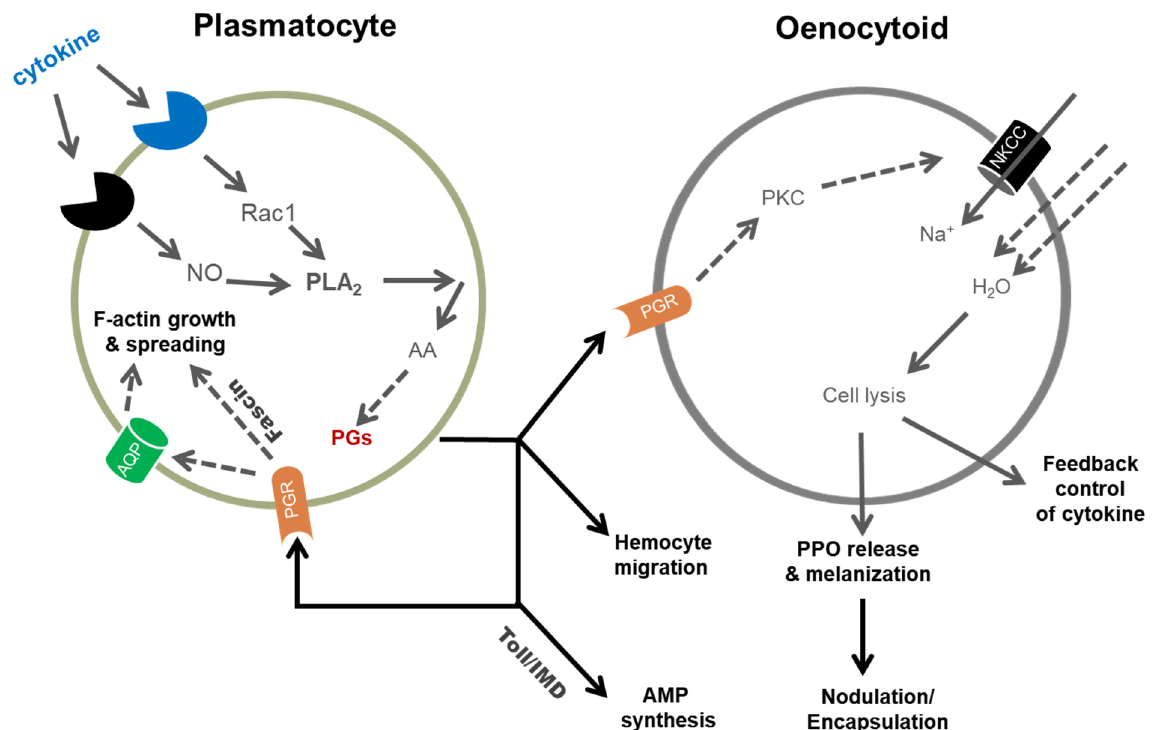
Figure 2. Prostaglandins (PGs) mediate cellular and humoral immune responses through specific receptors (PGRs). PGs are synthesized from arachidonic acid (AA), which is released from phospholipids by phospholipase A 2 (PLA 2 ) and is activated by immune challenge via cytokines or nitric oxide (NO). Oenocytoid cell lysis is mediated by PGR through a PKC pathway to activate a sodium-potassium-chloride cotransporter (NKCC), which generates an osmotic gradient that pulls water into the cell. Prophenoloxidae (PPO) is released from oenocytoid into hemolymph, where it is activated to phenoloxidase, which leads to melanin formation. In plasmatocyte, PGR activates cytoskeletal rearrangement via a small G protein Cdc42 and change cell volume via aquaporin (AQP) for hemocyte-spreading behavior. PGs also mediate antimicrobial peptide (AMP) synthesis via Toll/IMD immune signaling components.